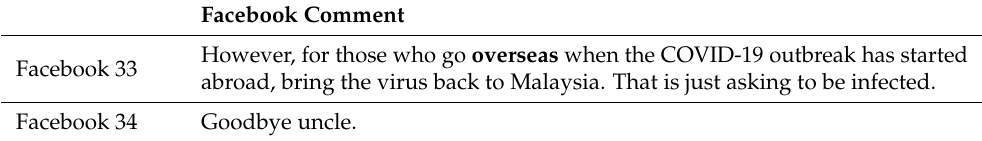
Table 3. Examples of stigmatization of COVID-19 patients from certain social classes in Facebook comments (N =